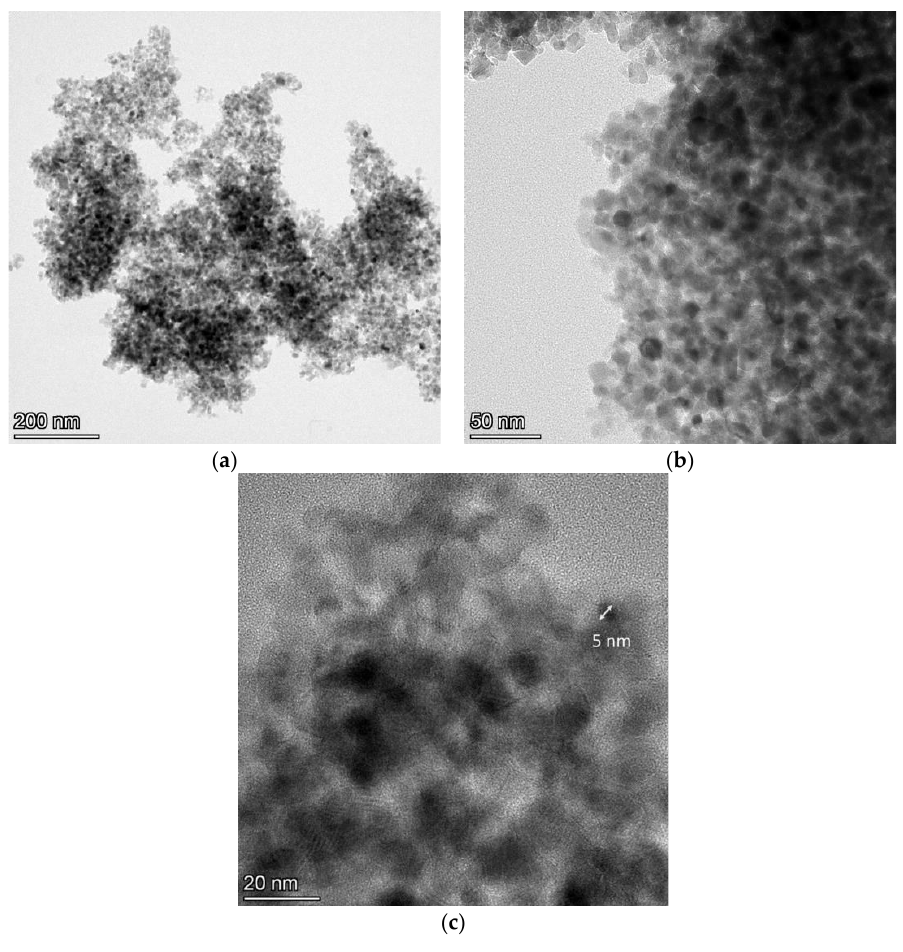
Figure 6. TEM images at ( a ) ×58,000, ( b ) ×190,000, and ( c ) ×500,000 magnification for the N-TiO 2 NPs.